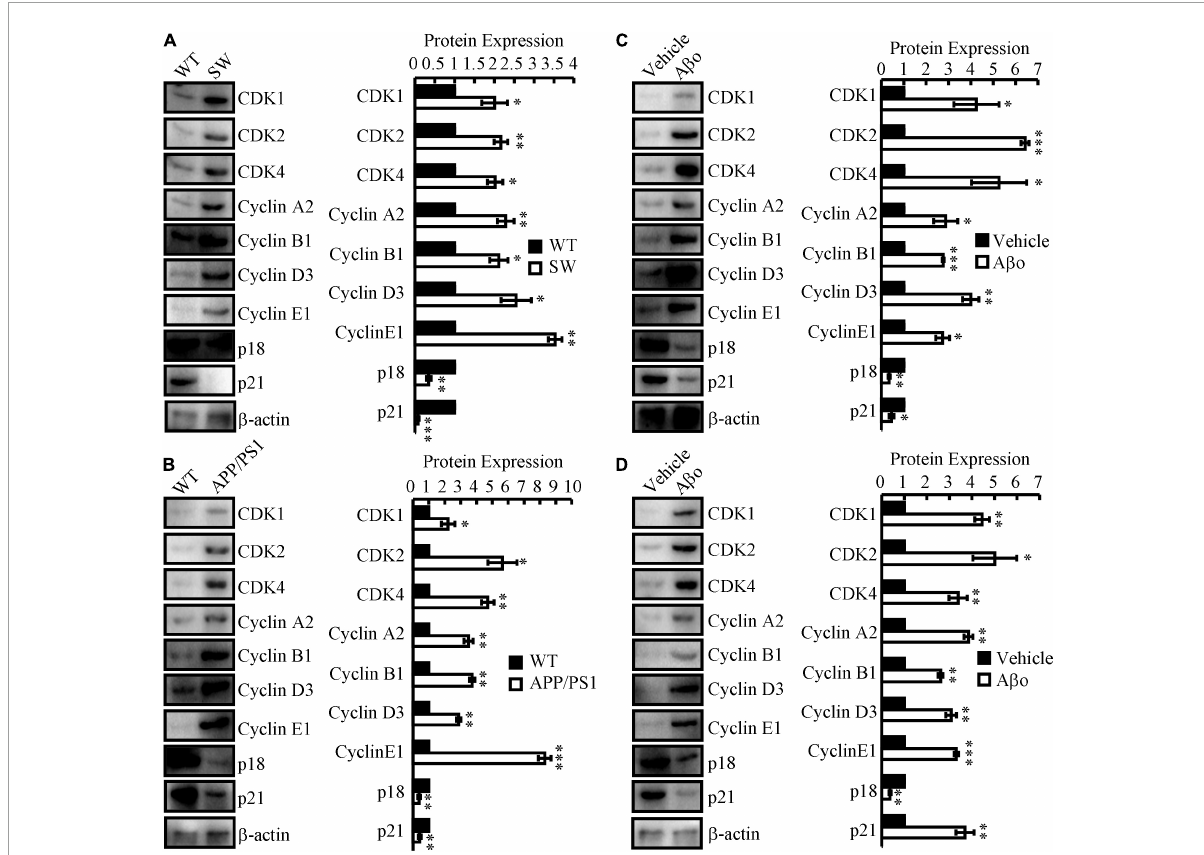
FIGURE2 The expression of cell cycle-regulated genes in in vitro and in vivo AD models. (A) N2a SW cells were established by transfecting N2a cells with swedish mutated APP plasmids. (B) The brains of 3-month-old APP/PS1 Tg mice were collected for the following experiments. (C) A β o was prepared to treat N2a cells at the concentration of 20 nM. (D) A β o (2 ng/5 µ l) was injected (i.c.v.) to the ventricles of C57BL/6 mice. (A–D) The total protein was extracted from the cells and brains. Western blotting was employed to detect the expression of CDK1/2/4, cyclin A2/B1/D3/E1, p18 and p21. β -actin served as an internal control. The optical density of the bands was analyzed using ImageJ software. Data are presented as the means ± S.E. of independent experiments, ∗ p < 0.05; ∗∗ p < 0.01, and ∗∗∗ p < 0.001 compared to the controls.